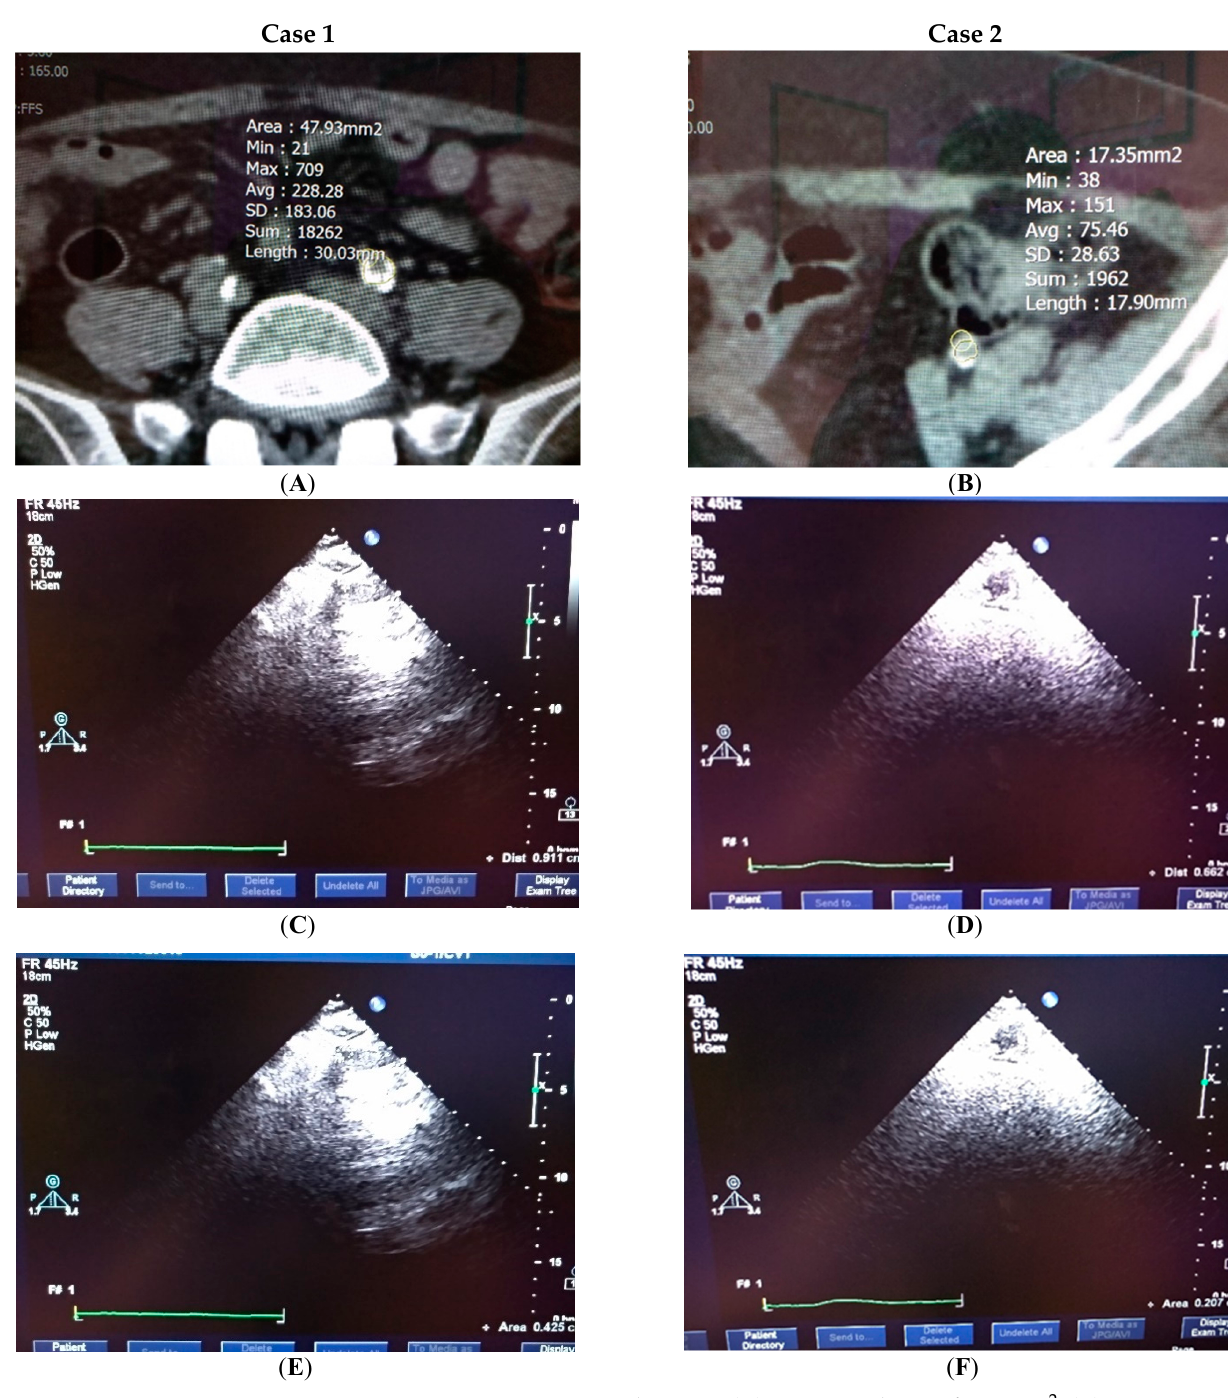
Figure 5. Two cases were reported. Case 1: ( A ) CT scanned area of 47.9 mm 2 , ( C ) conventional area of 36.8 mm 2 , and ( E ) optimal setting of the sonography scan featuring 42.5 mm 2 . Case 2: ( B ) CT scanned area of 17.4 mm 2 , ( D ) conventional setting of 24.1 mm 2 , and ( F ) the optimal setting of the sonography scan featuring 20.7 mm 2 .